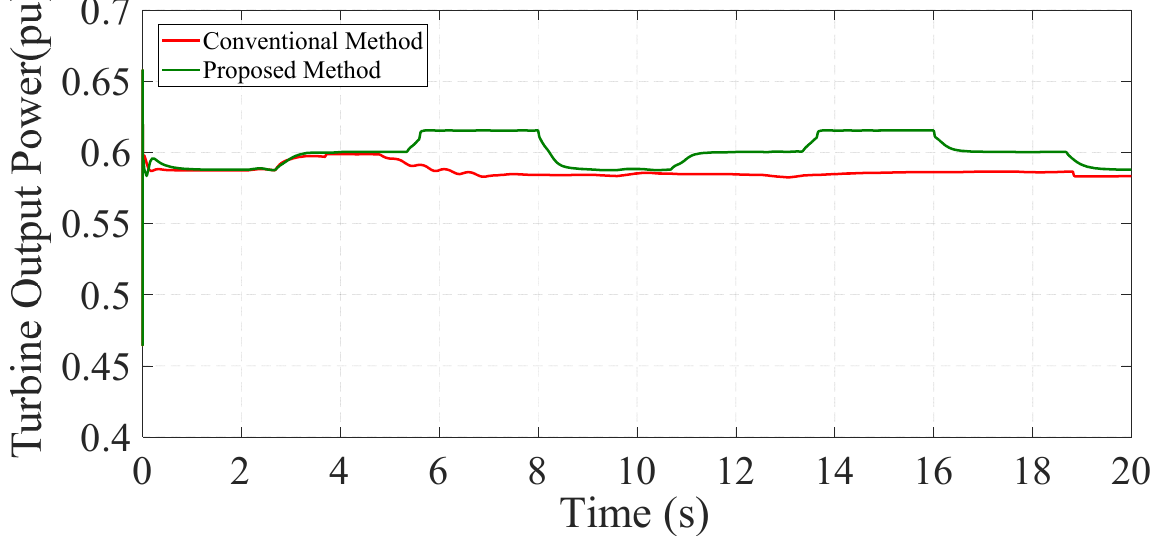
Figure 14. Comparison between the output power in the proposed system and the conventional method.